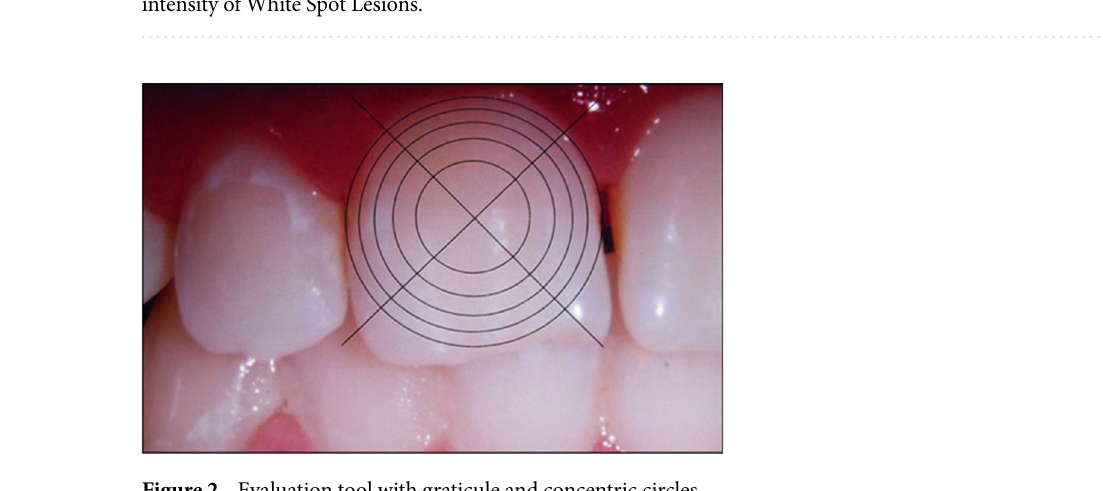
Figure 1. Description of the Enamel Decalcification Index (EDI) by Banks and Richmond to measure the intensity of White Spot Lesions.